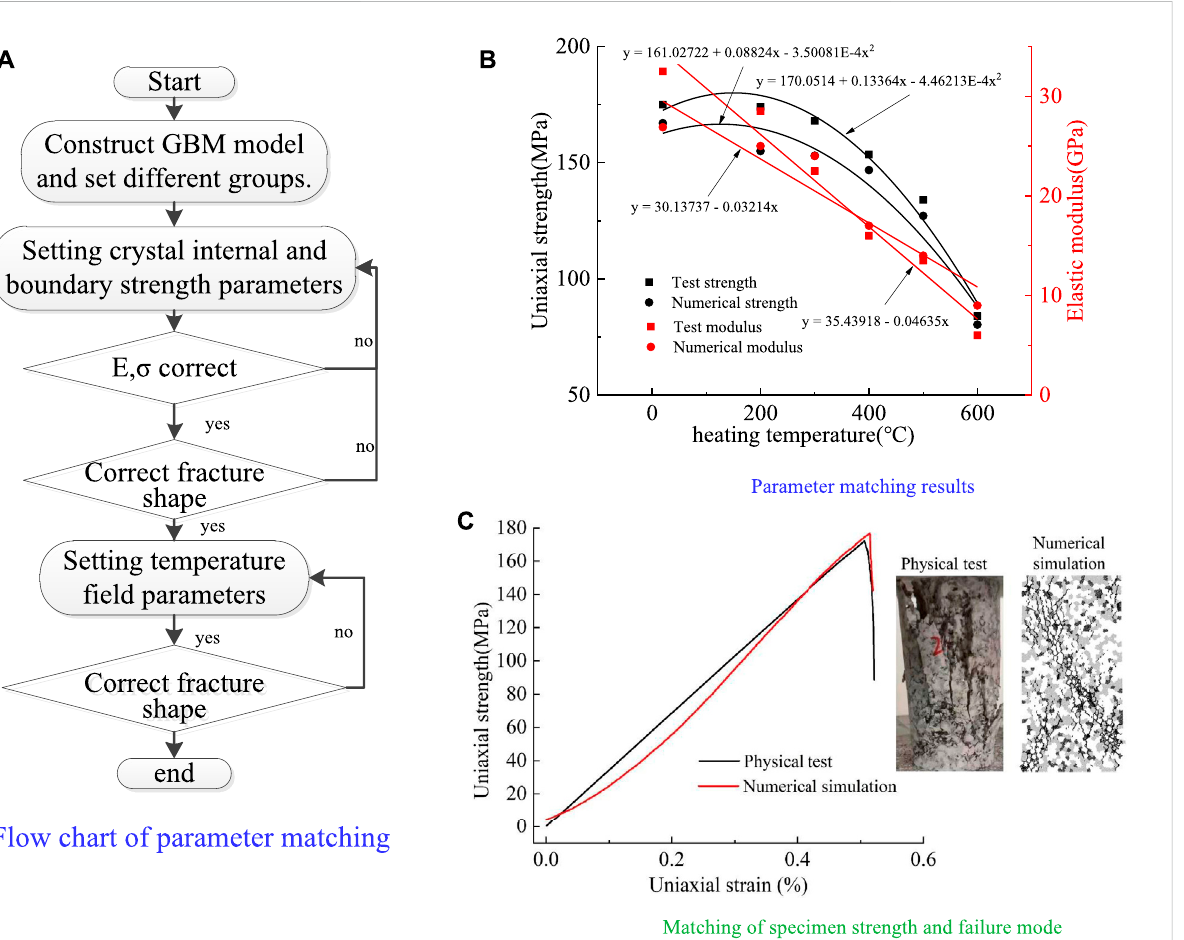
FIGURE 7 (A) Flow chart of parameter matching. (B) Parameter matching results. (C) Matching of specimen strength and failure mode.